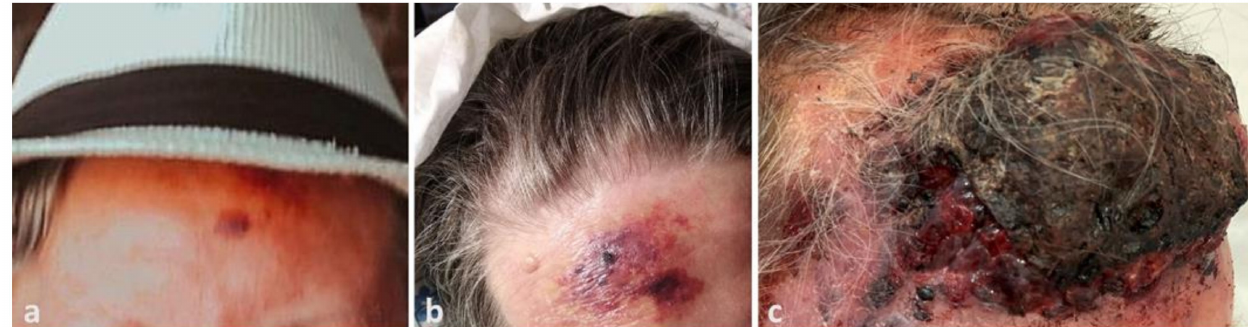
Figure 1. ( a ) Dramatic progression of angiosarcoma of the scalp, beginning as a small erythemato-violaceous patch on the patient’s forehead three months before admission, ( b ) extending to a large violaceous plaque on the patient’s forehead one month later, ( c ) and finally becoming a large, raised, necrotic and bleeding mass on the forehead with infiltrative plaques and nodules on the face three months later.